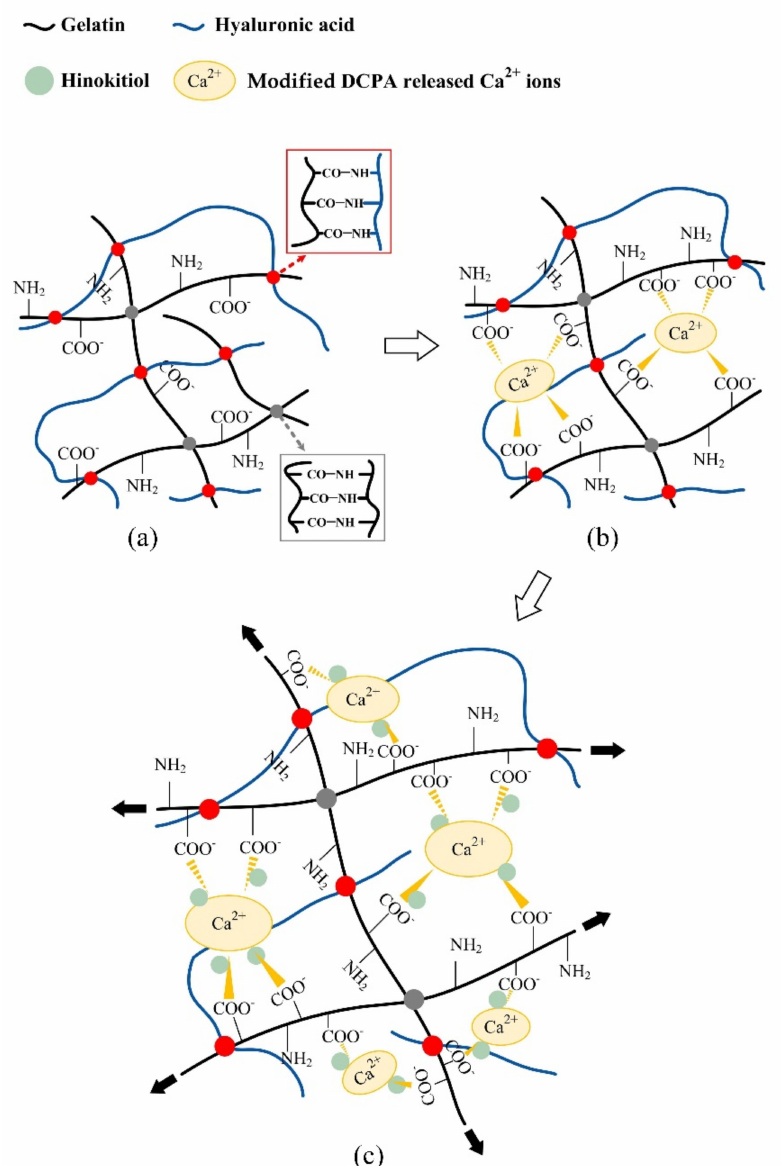
Figure 1. Schematic of a hydrogel composed of gelatin and hyaluronic acid without additives ( a ). Membranes with added modified DCPA show that the Ca 2+ released by modified DCPA forms a physical bond with the carboxylic acid on the gelatin molecular chain, thereby inducing an ion–dipole bond between gelatin molecules ( b ). Adding a modified DCPA membrane and impregnating it with hinokitiol reduces the physical ion–dipole binding force between the gelatin molecules and allows for easy deformation because the long main chain of hyaluronic acid slides under tension, thereby reducing the elastic modulus of the hydrogel membrane ( c